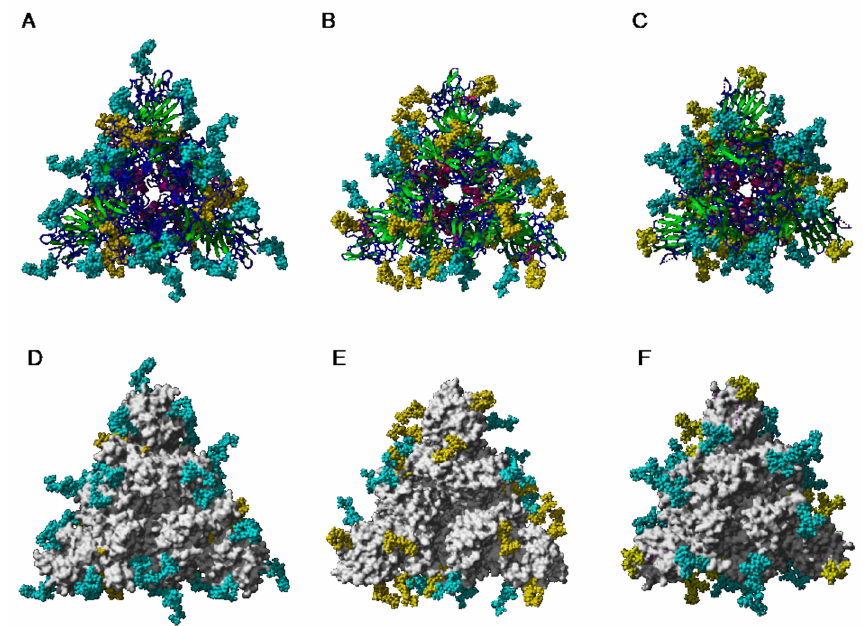
Figure 29. ( A – C ). Top face of the ribbon diagram representing the homotrimeric spike of SARS-CoV (PDB code 6ACD) ( A ), MERS-CoV (PDB code 5W9H) ( B ), and SARS-CoV-2 (PDB code 6VXX) ( C ). High-mannose glycans and complex glycans are colored yellow and cyan, respectively. ( D – F ). Top face of the molecular surface (colored grey) of the S-glycoprotein of SARS-CoV ( D ), MERS-CoV ( E ), and SARS-CoV-2 ( F ). High-mannose glycans and complex glycans are colored yellow and cyan,